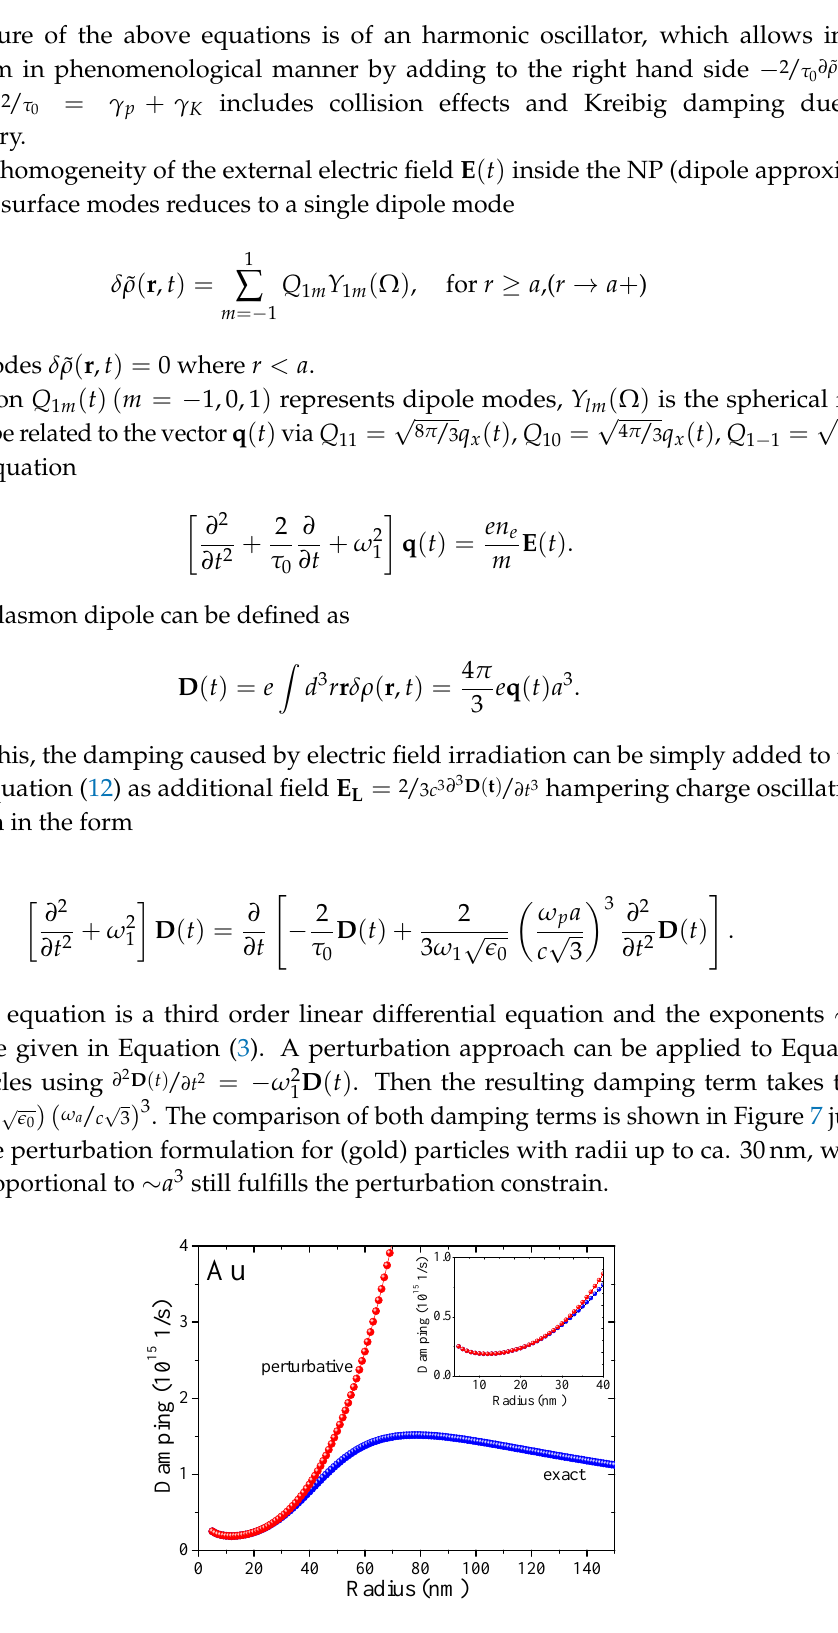
Figure 7. Comparison of RPA damping rates. The perturbative solution (red) and exact Lorentz friction (blue) for a Au nanoparticle in